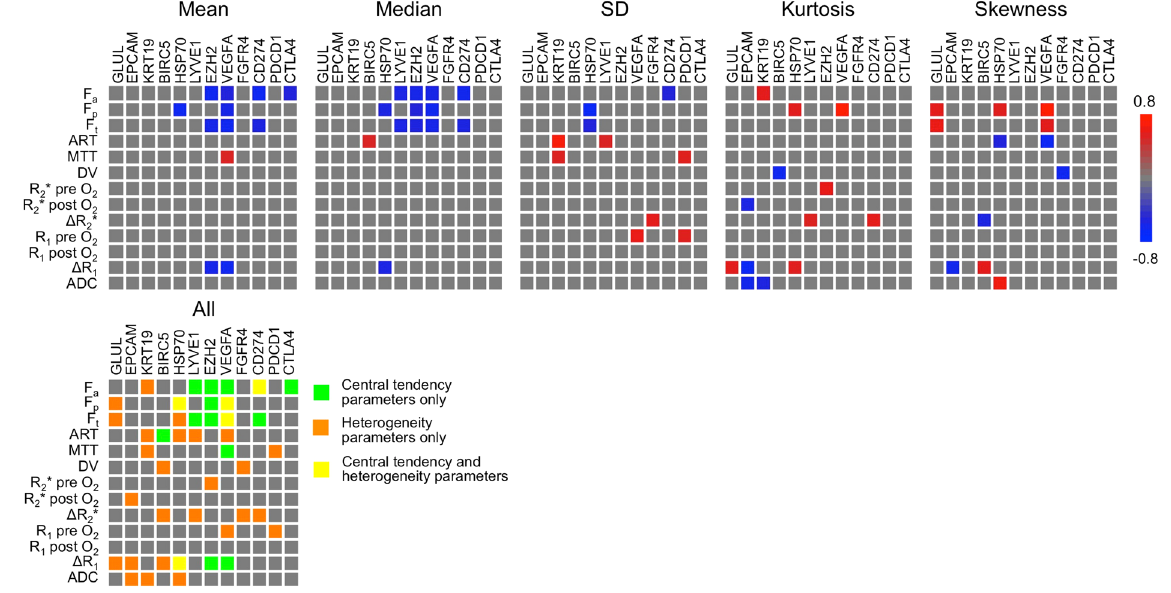
Figure 6. Heatmaps of correlations between MRI parameters and gene expression levels in 14 HCC lesions in 14 patients. Significant correlations ( P < 0.05) are coloured according to the scale bar. A combined heatmap of all MRI features is shown at the figure bottom, illustrating additional information provided by heterogeneity parameters (SD, kurtosis and skewness) compared to central tendency parameters (mean and median) with respect to correlations between MRI and gene expression levels. ADC = apparent diffusion coefficient, ART = arterial fraction, BIRC5 = Baculoviral IAP repeat containing 5, CD274 = cluster of differentiation 274, CTLA4 = cytotoxic T-lymphocyte-associated protein 4, DV = distribution volume, EPCAM = epithelial cell adhesion molecule, EZH2 = enhancer of zeste homolog 2, F a = arterial flow, FGFR4 = fibroblast growth factor receptor 4, F p = portal flow, F t = total flow, GLUL = glutamate-ammonia ligase, HSP70 = 70 kilodalton heat shock protein, KRT19 = keratin 19; LYVE1 = lymphatic vessel endothelial hyaluronan receptor 1, MTT = mean transit time, R 1 = longitudinal relaxation rate, R 2 * = transverse relaxation rate, VEGFA = vascular endothelial growth factor